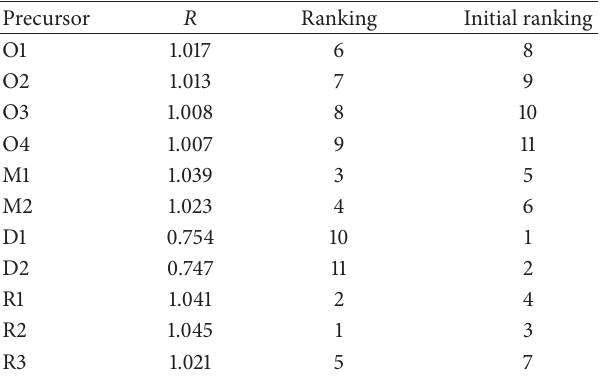
Table 12: Comparison of precursors before and after the update of prior